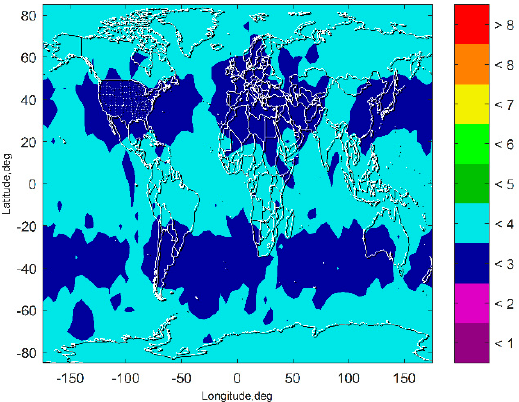
/ INS ARAIM after Figure 11. EMT-I of the subset-reduced GNSS/INS ARAIM after exclusion. Figure 11. EMT-I of the subset-reduced GNSS Figure 11. EMT-I of the subset-reduced GNSS/INS ARAIM after exclusion.